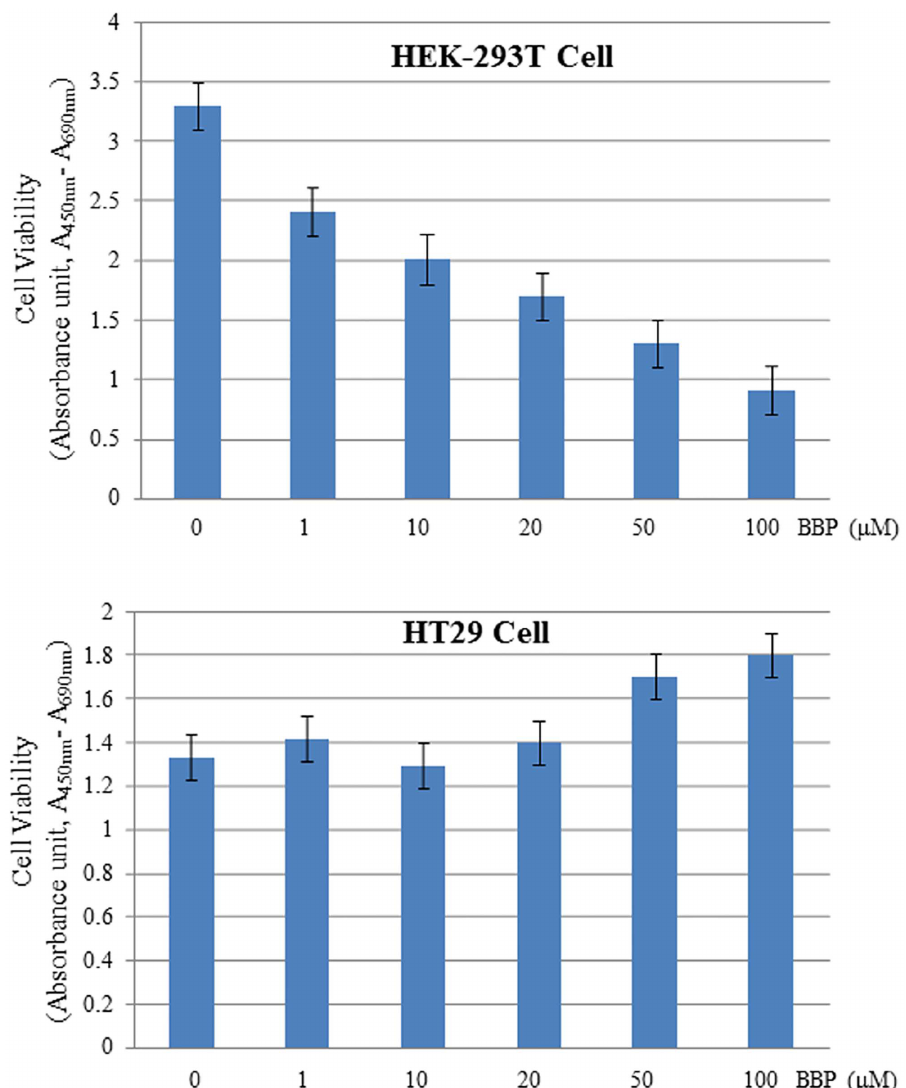
Fig 6. The effects of BBP on cell proliferation. Both HEK-293T and HT-29 cells were cultured to 80% confluencyand treated with BBP at a series of concentrations as indicated. After the treatment for 24 hrs, the cell viabilitywas measuredas describedin the “Materialsand methods”. Each concentration point was repeatedthree times, and the means were shown with